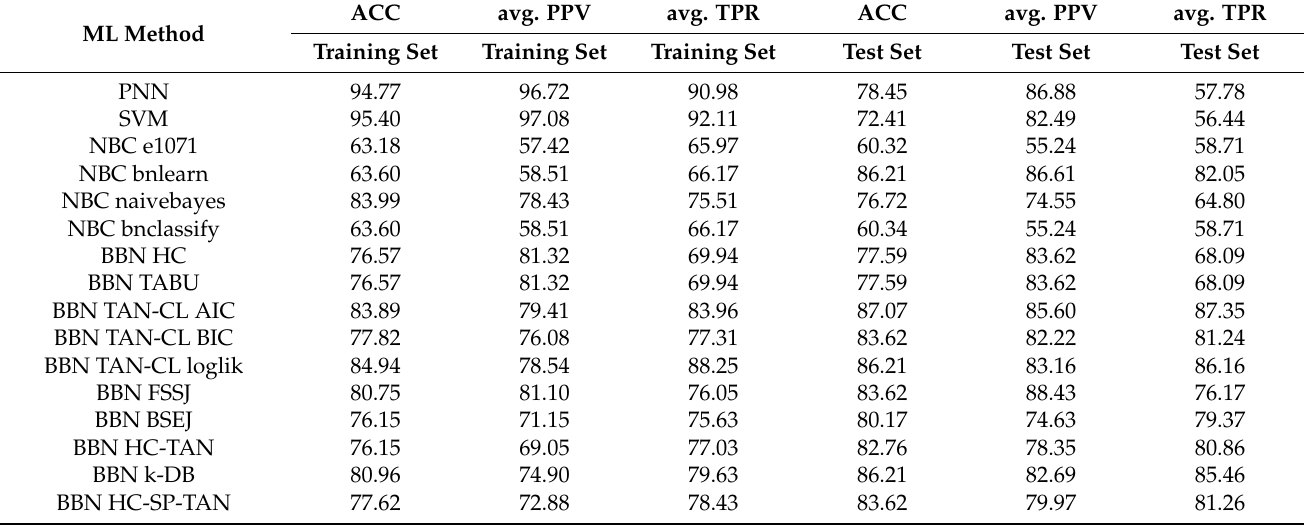
Table 7. Comparisons of classification parameters for all used ML